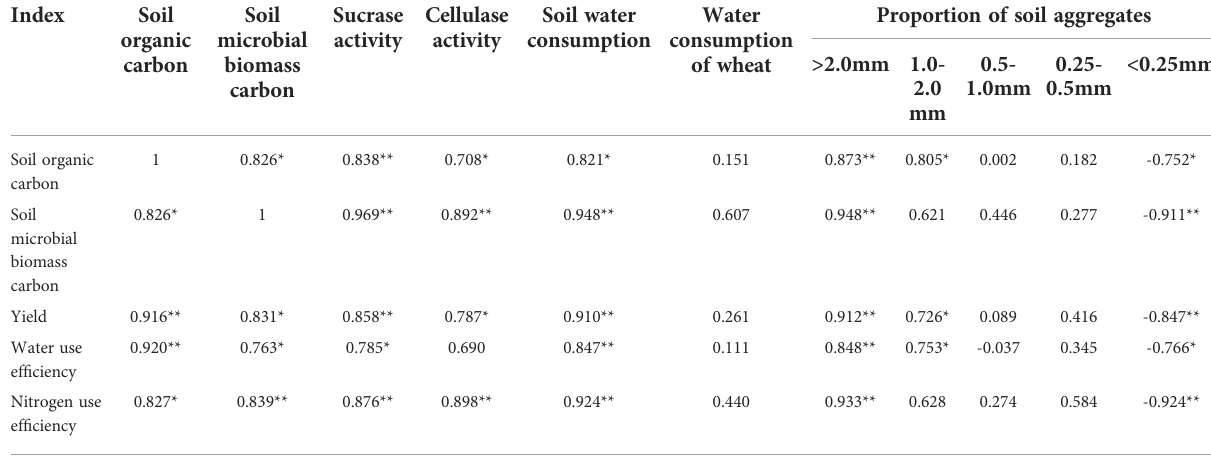
TABLE 6 Relationships among soil organic carbon, soil microbial biomass carbon, soil enzyme activity, soil water consumption, water consumption of wheat, soil aggregates, yield, water and nitrogen use ef fi ciency.